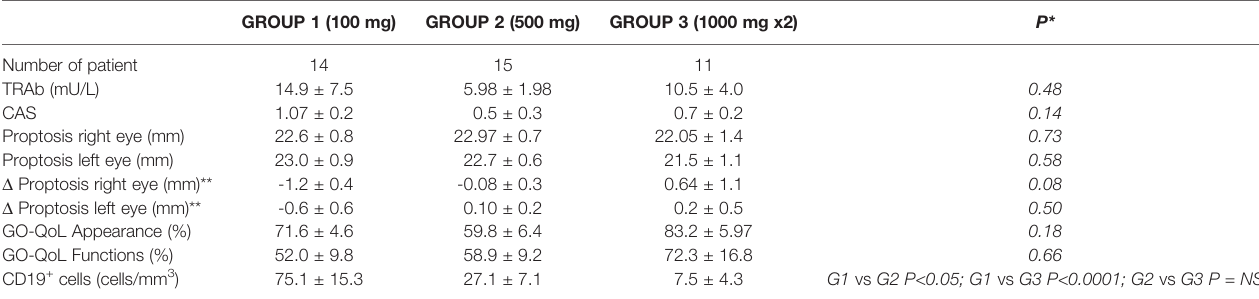
TABLE 3 | Clinical outcome of patients with moderate severe GO assessed 24 weeks after therapy with different doses of